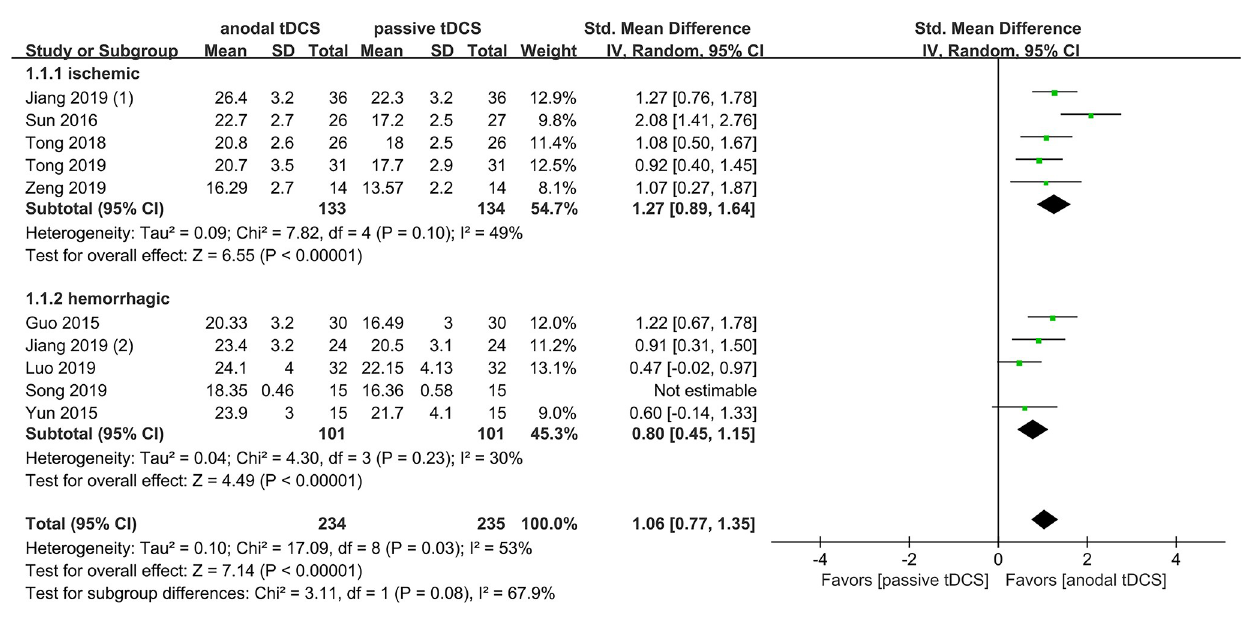
Fig 4. Subgroup analysis based on different type of stroke.